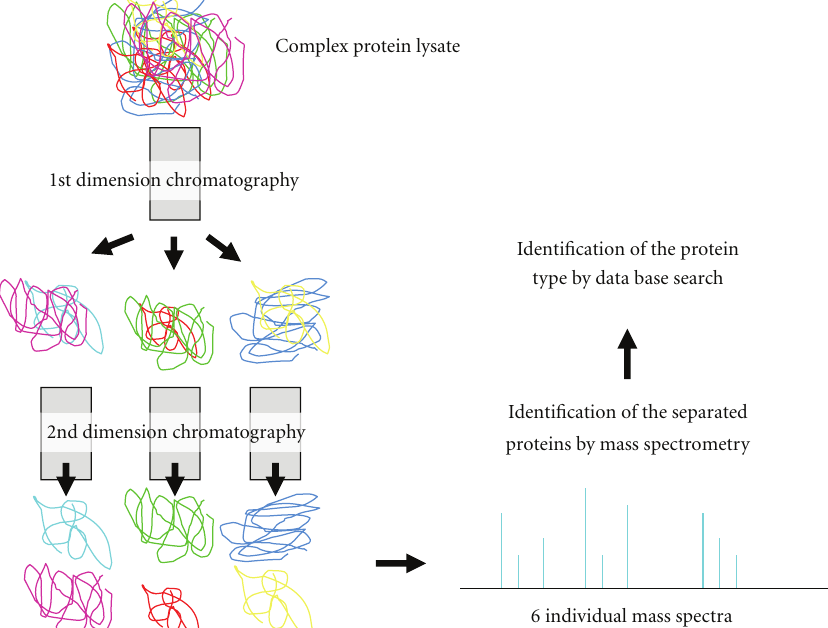
Figure 3: Shotgun proteomics or MudPIT uses multidimensional chromatographic separation to reduce complexity of protein lysates. The selection of the type of chromatographic columns depends on the question asked and the technical equipment. The di ff erent protein lysate fractions obtained by chromatographic separation ideally contain only one protein type which is subsequently identified by mass spectrometric analysis and data base